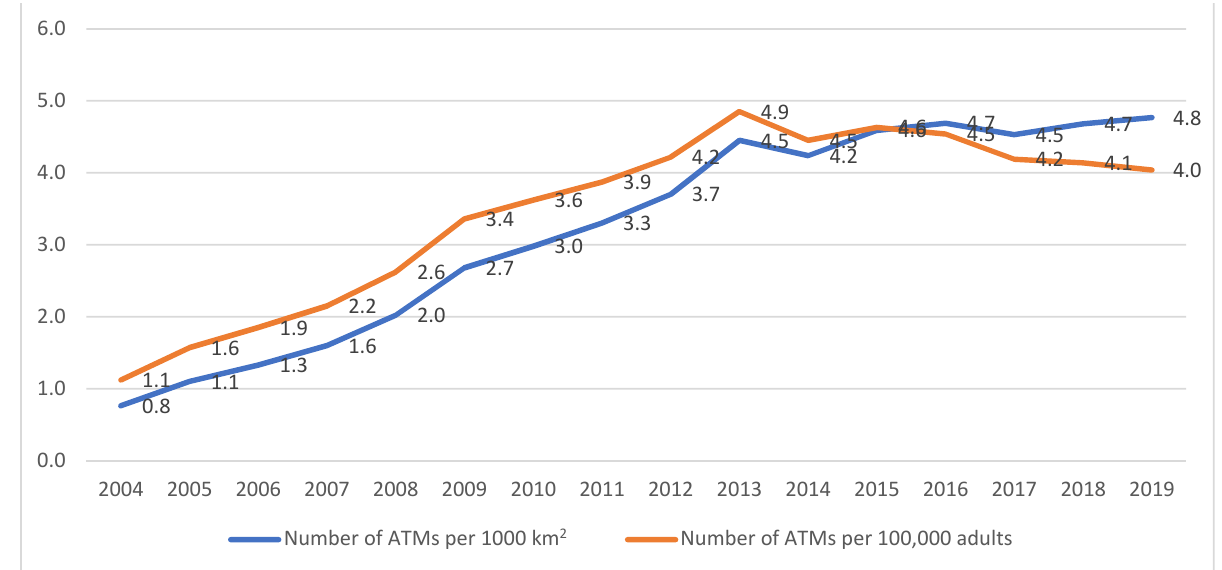
Figure 2. Number of ATMs per 1000 km 2 and Number of ATMs per 100,000 adults.